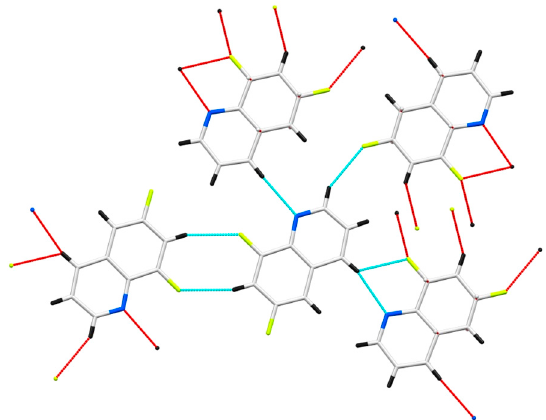
Figure 2. Aggregates of 6,8-difluoroquinoline 6b that shows H-7 and F-8 H-bonding.